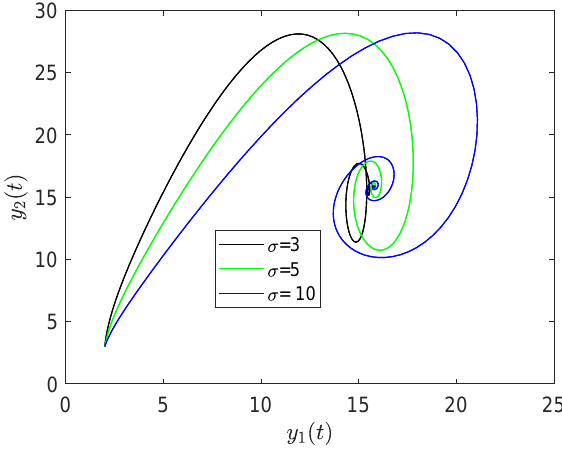
Figure 47. Phase portraits of y 1 and y 2 when varying σ .